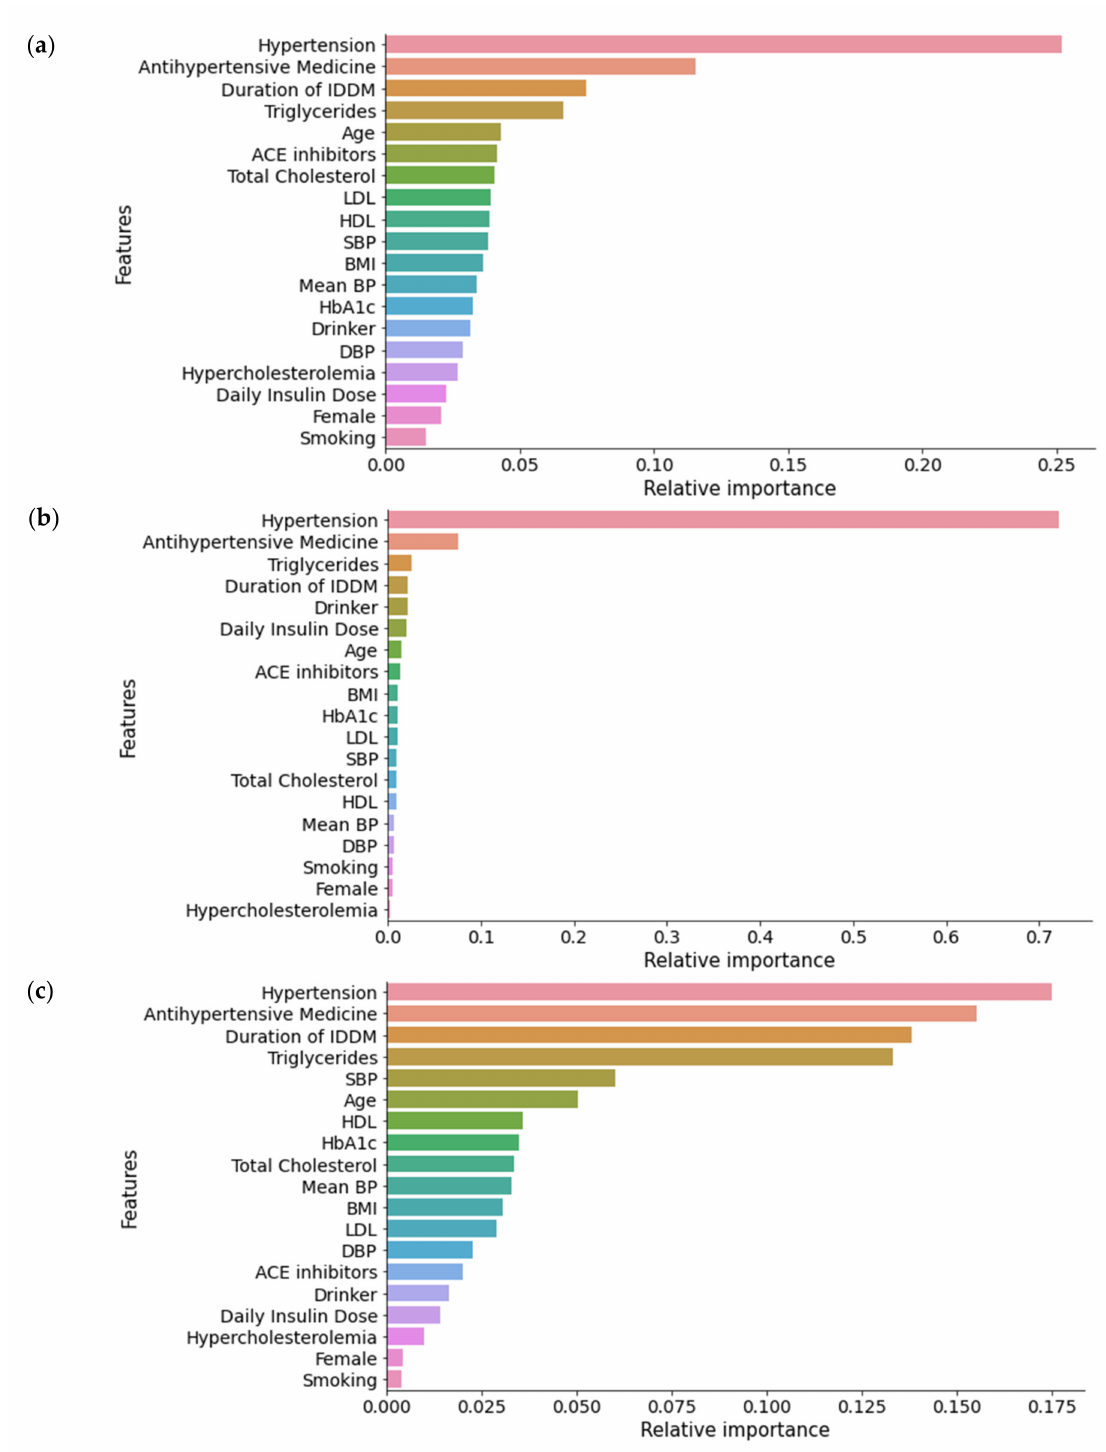
Figure 3. Feature ranking on Dataset KNN: ( a ) Extra Tree algorithm; ( b ) XGB algorithm; ( c ) RF